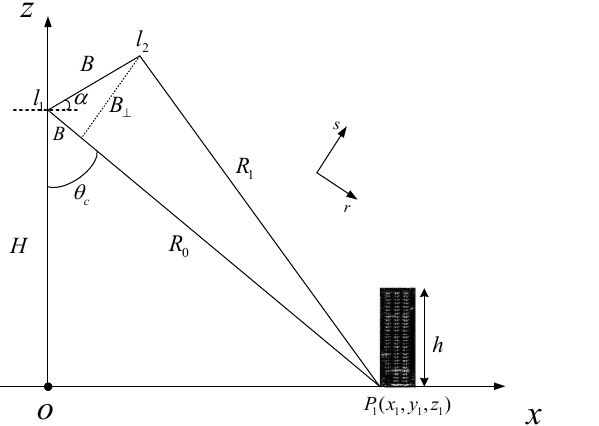
the scene, A m , l n , and H are the azimuth position of the radar at the moment of m th pulse, the position of the n th array element, and the platform height, respectively.